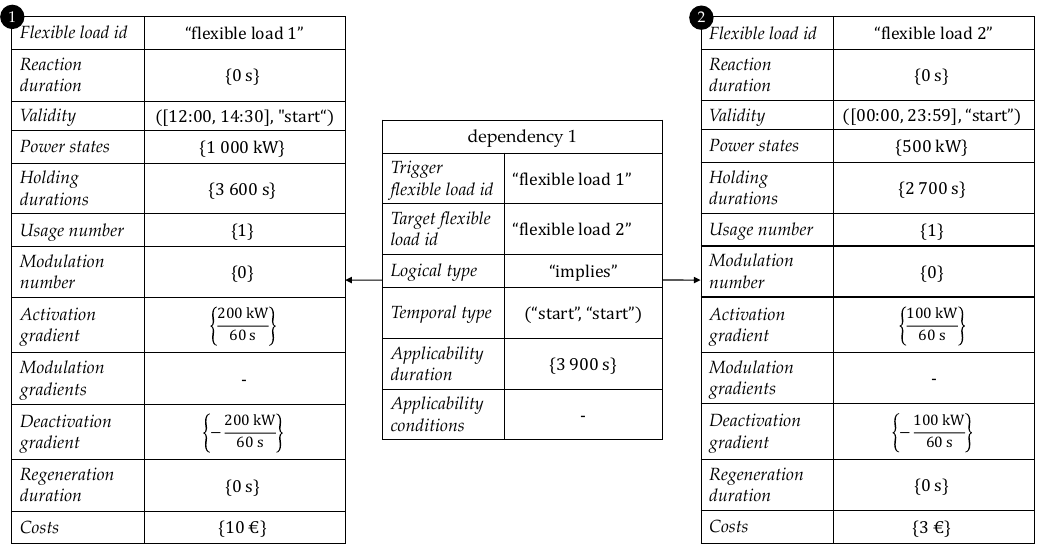
Figure 6. The data model for the exemplary scheduling